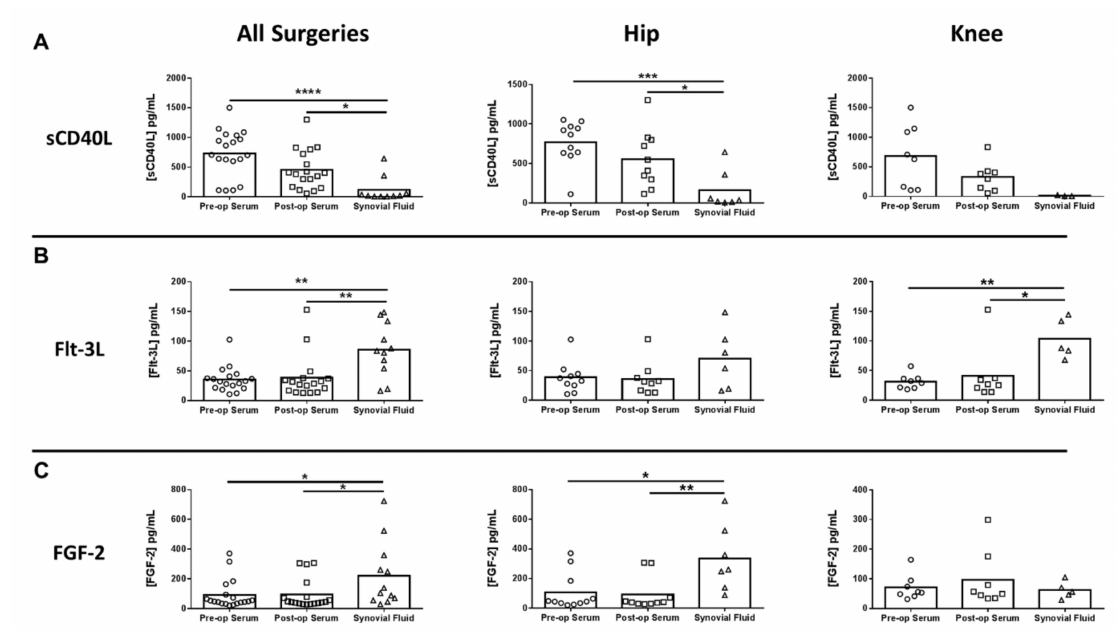
Figure 5. Di ff erentially expressed mediators in the synovial fluid of hip / knee arthroplasty patients. Quantitation of ( A ) soluble CD40 ligand (sCD40L), ( B ) Fms-like tyrosine kinase 3 ligand (Flt-3L), and ( C ) basic fibroblast growth factor (FGF-2) expression in pre- and post-sera and synovial fluid collected from THA ( n = 11) and TKA ( n = 8) subjects (* p < 0.05; ** p < 0.01; *** p < 0.001; **** p < 0.0001; one-way ANOVA).